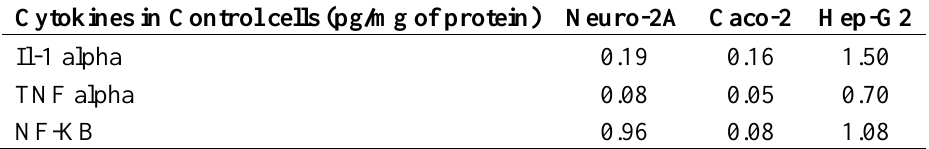
Table 12. Amounts of cytokines and transcription factors in the control cells in the absence of PHMB, as measured using different commercially available kits.